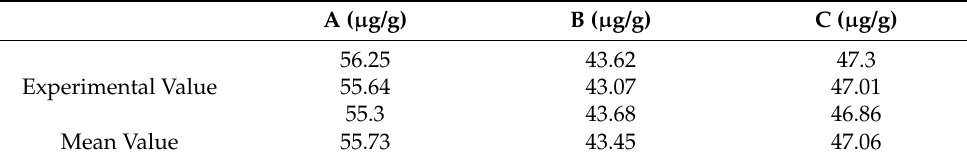
Table 4. Determination of the selenium